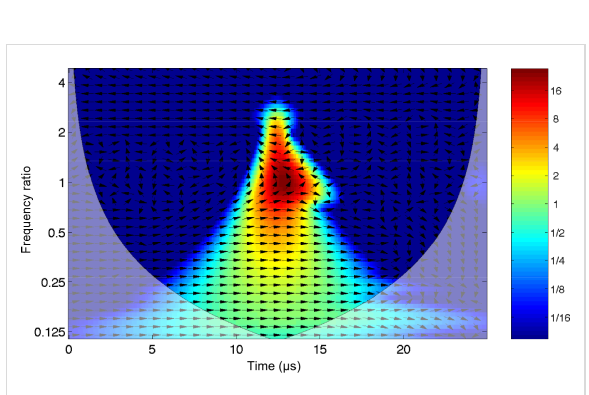
Figure 6: Wavelet cross-correlation between the sinc driver and the response of the damped harmonic oscillator (quality factor Q = 40), as shown in Figure 5.